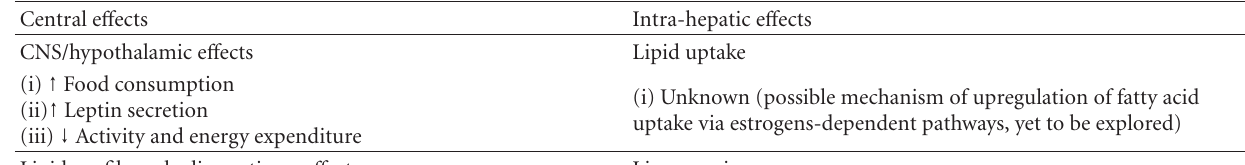
Table 1: Summary of the central and intrahepatic e ff ects resulting in liver fat accumulation with estrogens